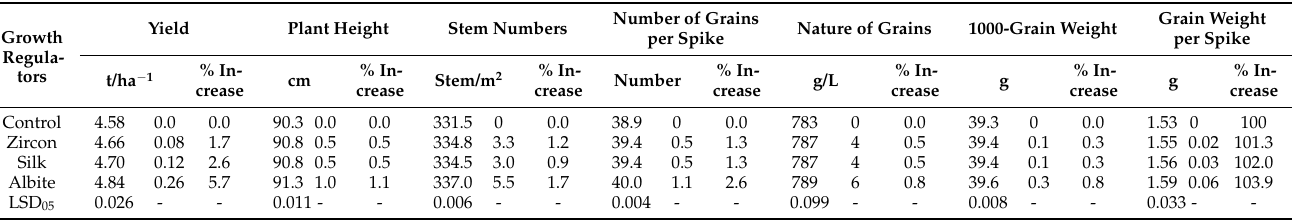
Table 3. Wheat components affected by the influence of growth regulator applications (average for